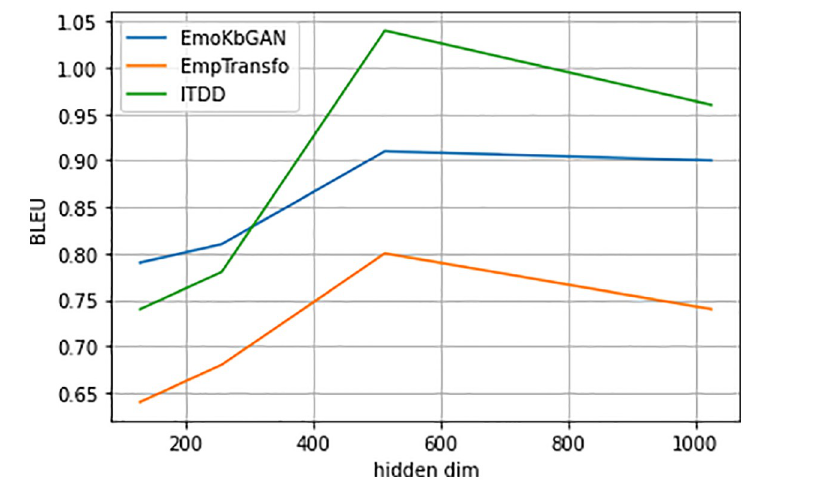
Fig 3. BLEU vs hidden size.